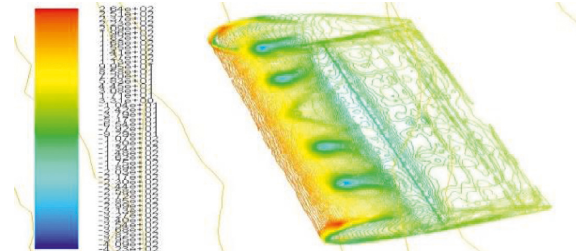
Figure 9: Total pressure at 10 ° AOA for the 1st module.